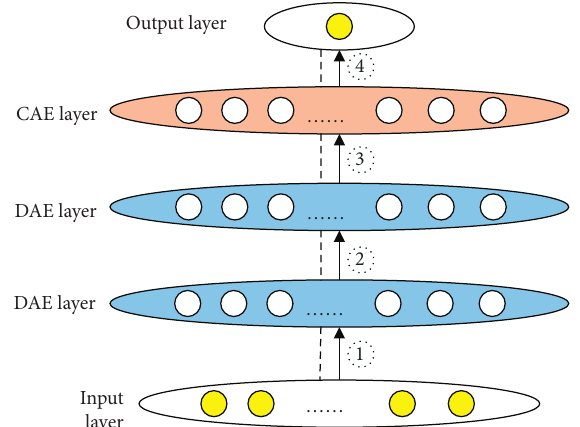
Figure 1: Deep autoencoder network structure.